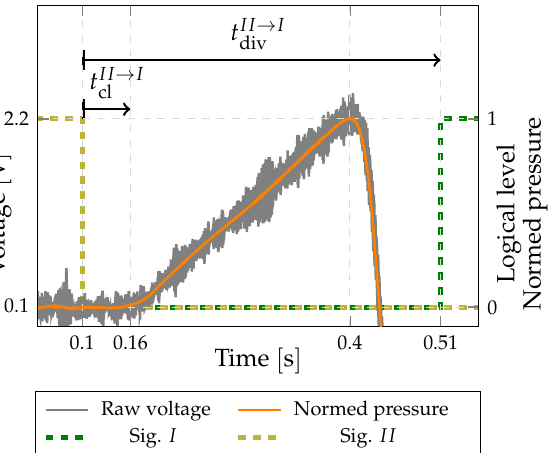
Figure 5. Example of recorded voltage from the piezo pressure sensor together with signals from inductive